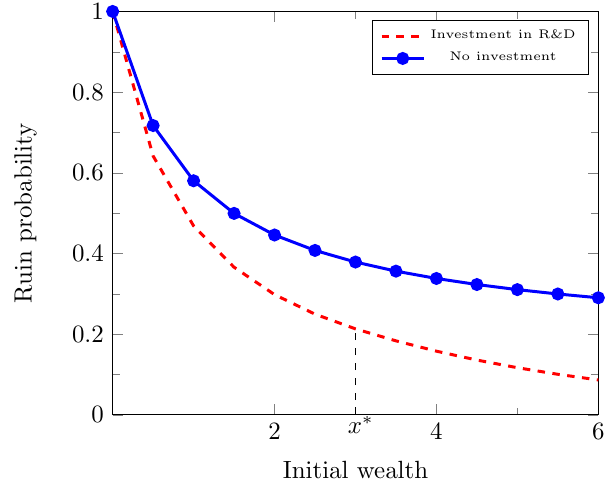
Figure 5. Illustration of the ruin probability without any investment (blue curve with circle markers), the minimized ruin probability with investment in research and development (red dashed curve). The x -axis denotes the initial wealth of the underlying company and the y -axis denotes the (minimized) ruin probability. x ∗ on the x -axis is the critical threshold above which the optimal strategy is to invest as much as possible in R&D, and below which the optimal strategy is not to invest at all in R&D. Here, we take ρ 0 = 1 (irrelevant), ν = 0.1, λ 0 = 1.2, δ 0 = 0.4 and c 1 = c 2 = 1 (irrelevant) and γ =